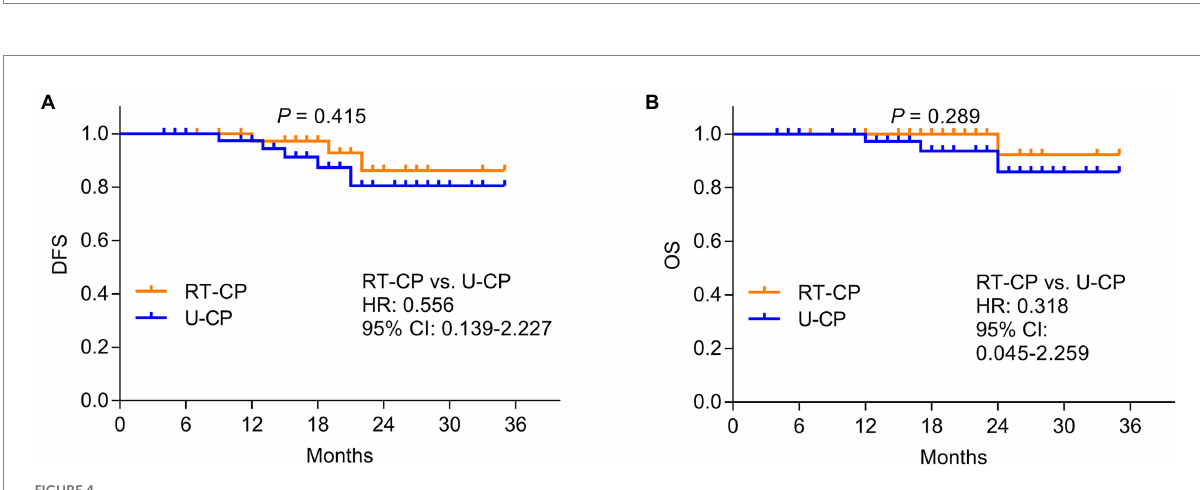
FIGURE 4 Comparison of DFS and OS between RT-CP group and U-CP group. disease-free survival (DFS) (A) and overall survival (OS) (B) were not different between the RT-CP group and the U-CP